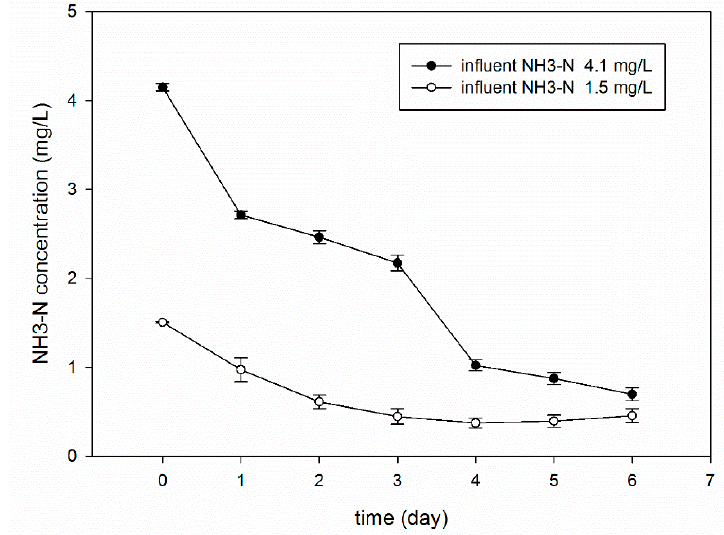
ff erent influent